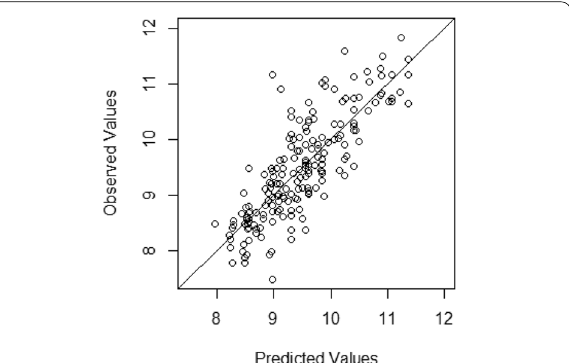
Fig. 5 Scatter plot of predicted and observed values of Analysis 1 (Yamaha). The unit of the axes is the logarithm of winning bid price